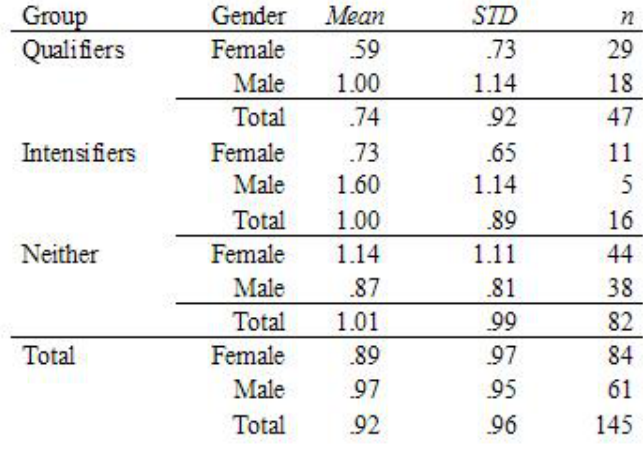
Note: Based on messages posted by 22 females and 10